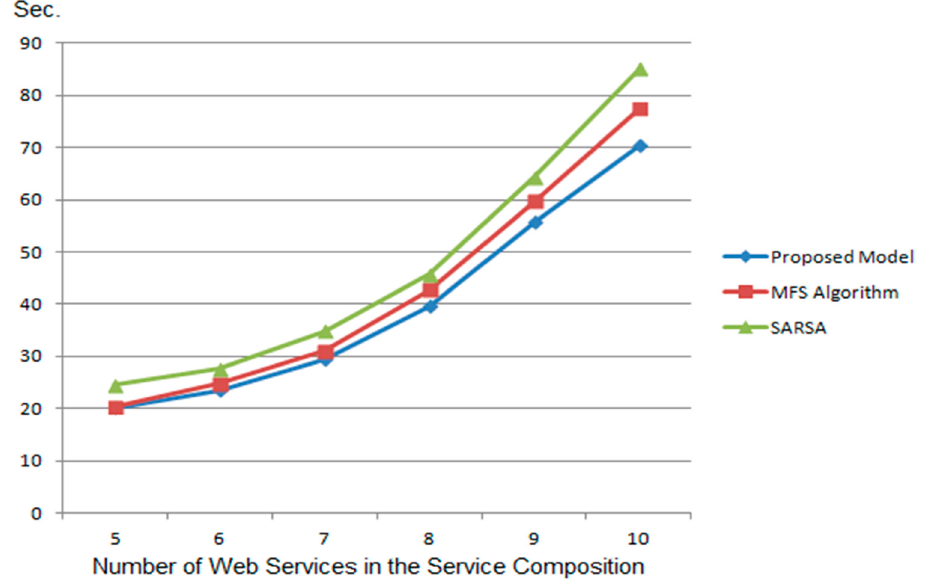
Figure 3. Service composition construction time when the composition threshold = 100.